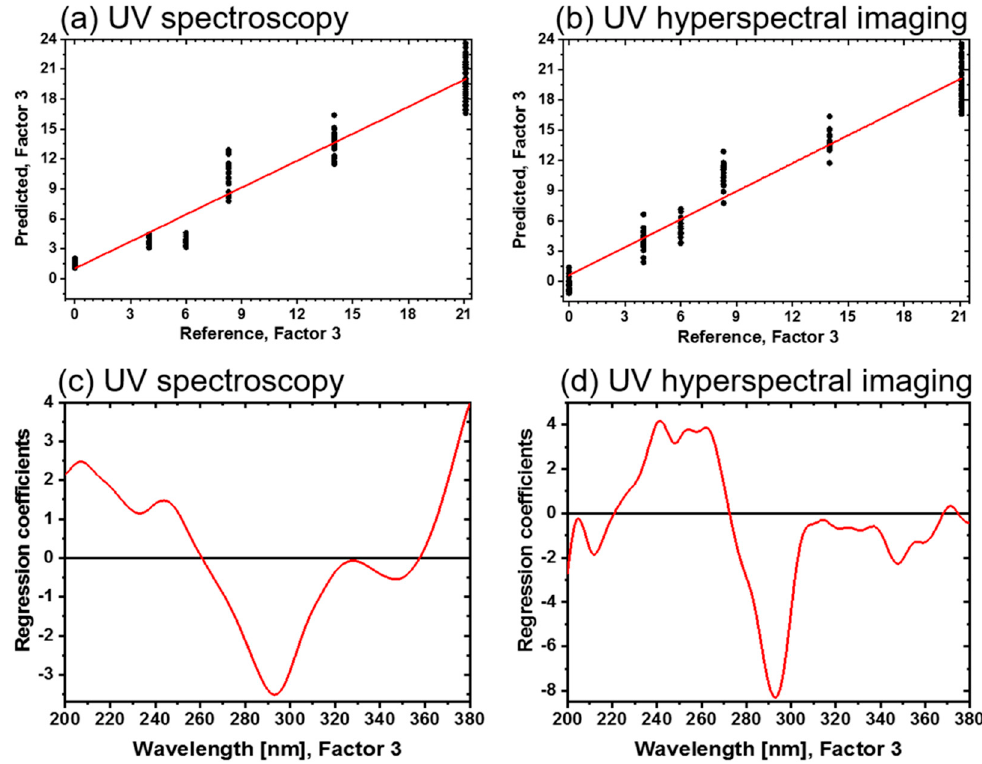
Figure 7. Three-factor PLS-R models for the oxide layer thicknesses of direct bonded copper in the UV region (200–380 nm). ( a ) Predicted vs. reference of UV spectra. ( b ) Predicted vs. reference of UV hyperspectral imaging. ( c ) Regression coefficients of the UV spectra. ( d ) Regression coefficients of the UV hyperspectral imaging.